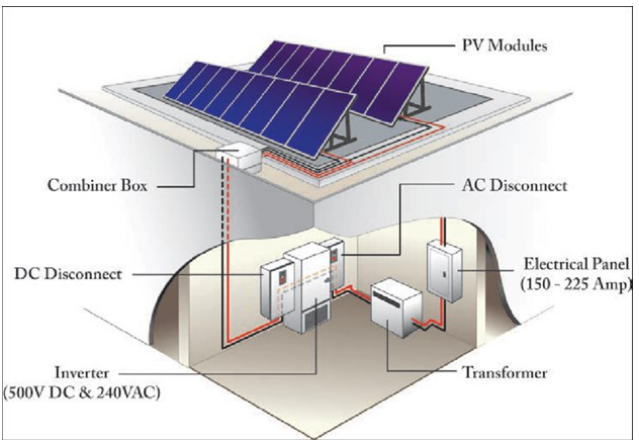
Figure 1. Grid-connected (PV) inverter system